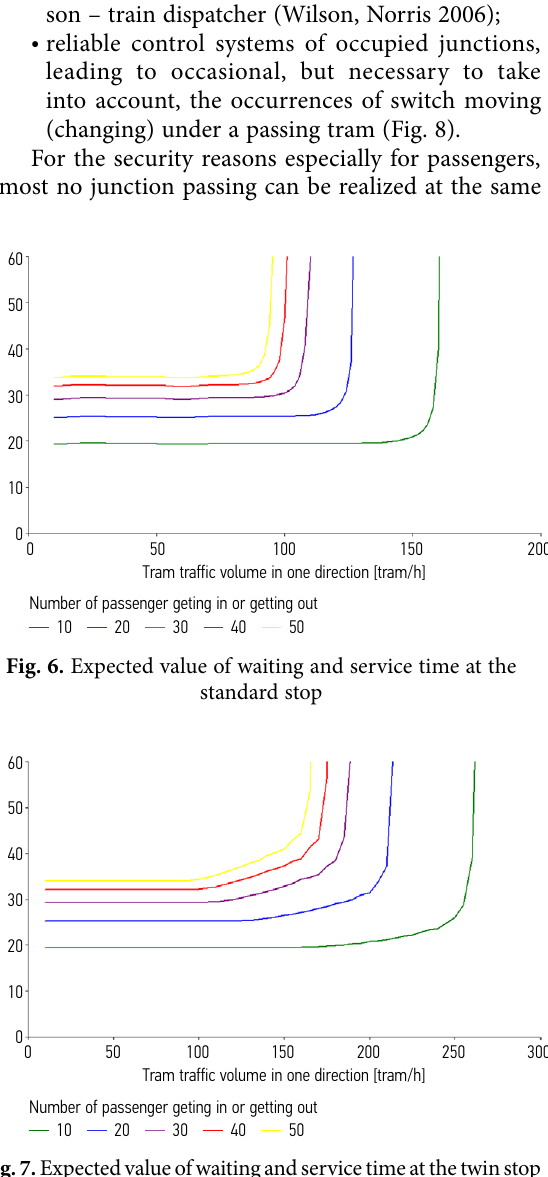
Fig. 7. Expected value of waiting and service time at the twin stop